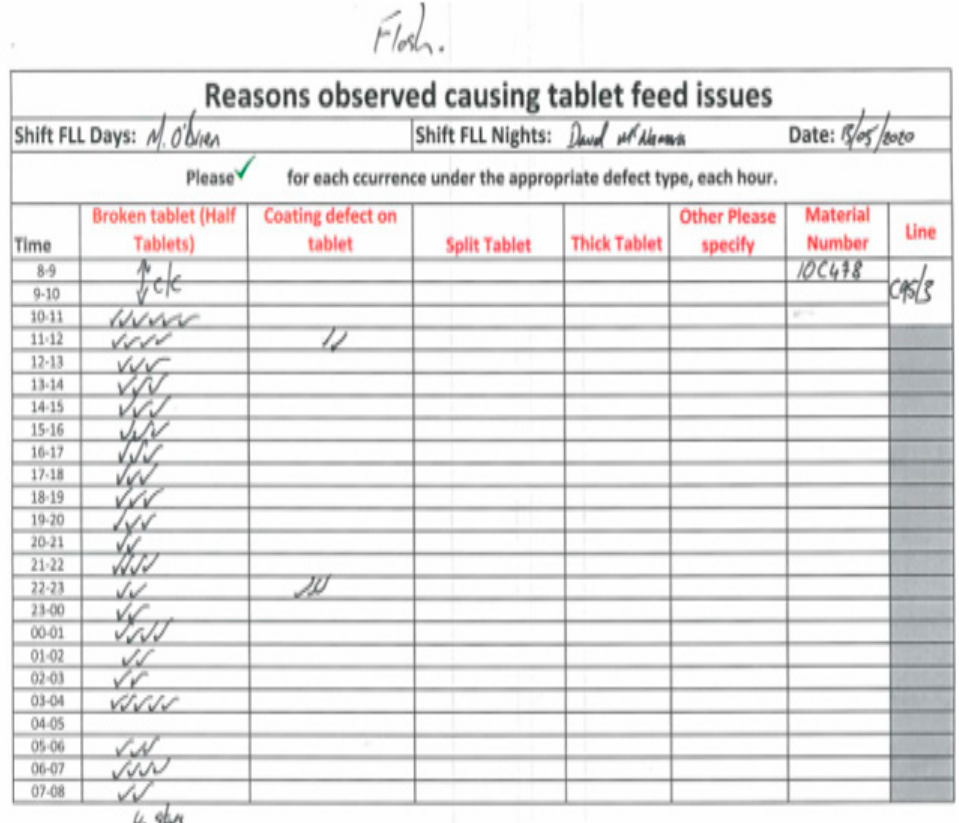
Figure 9. An example of a check sheet exercise run on one shift to breakdown occurrences of defect types. Every time an operator ha a broken tablet, coating defect, split table or thick tablet, they recorded the issue with a “tick”. Visually, it can be seen that most (or all) of the “checks” or “ticks” are under the broken tablet (half tablet) category.